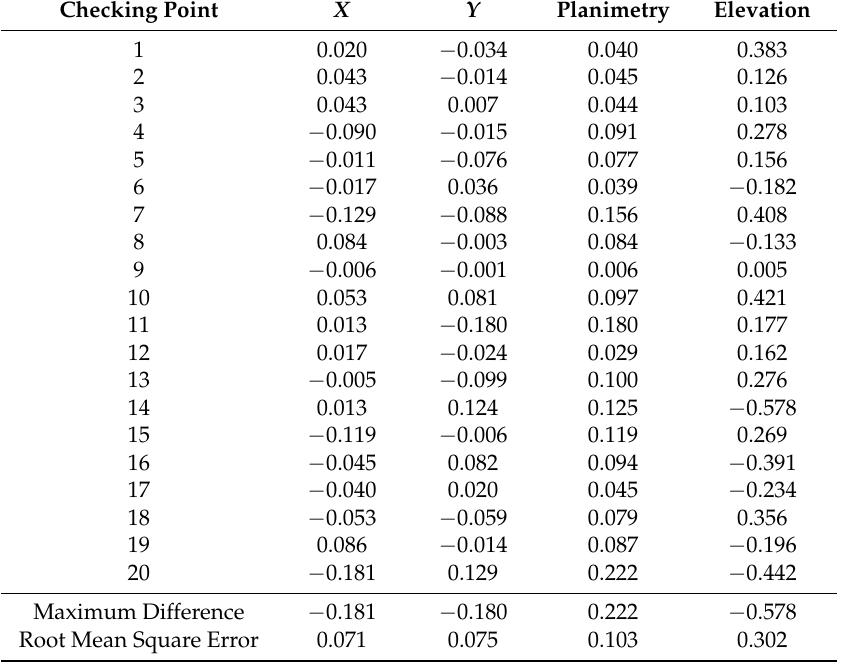
Table 3. Difference of Coordinates of the Checking Points (Unit: